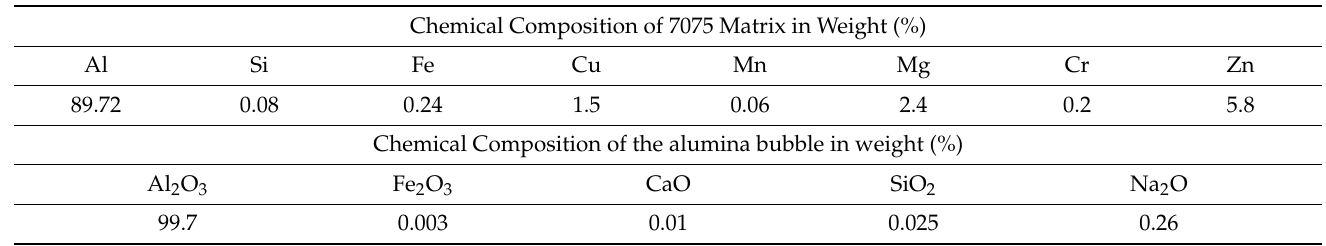
Table 1. Chemical composition of 7075 syntactic foam (supplier data).